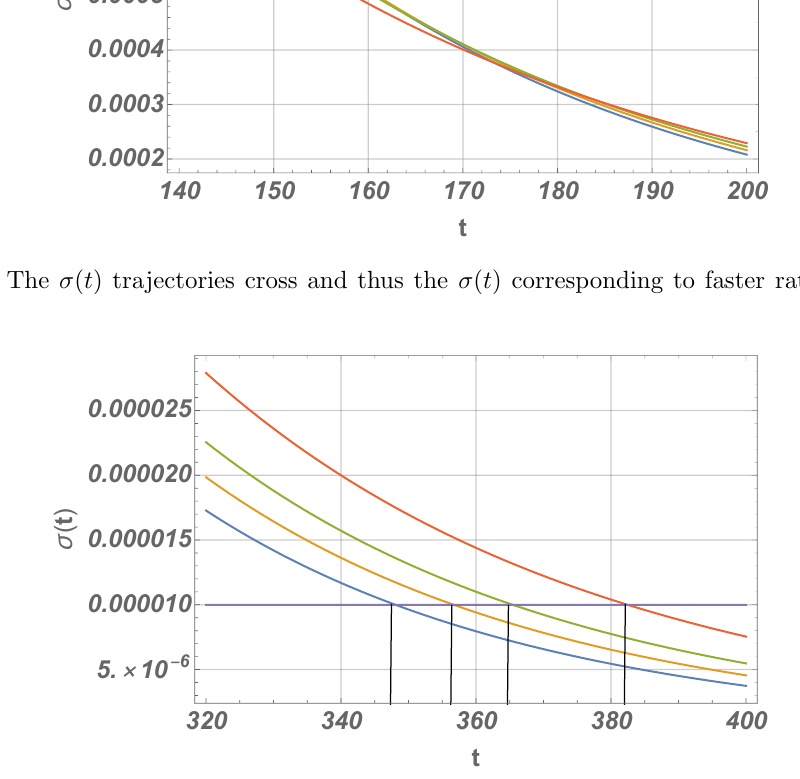
Figure 8 . The zero times are the places in the t -axis where the black straight lines intersect. Under chiral